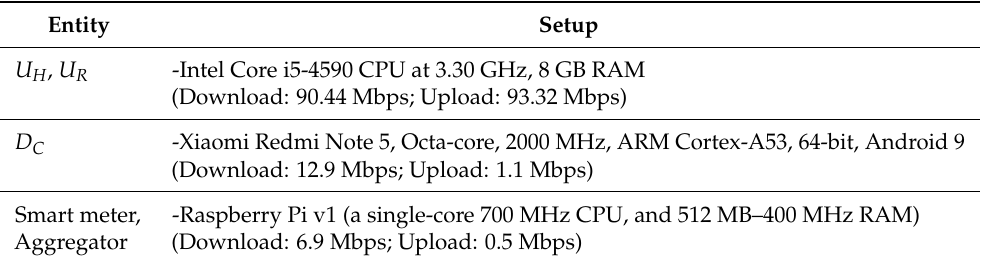
Table 3. P4G2Go testbed parameters.